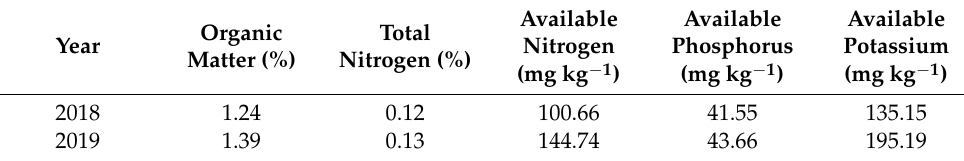
Figure 2. Daily solar radiation, rainfall, and maximum and minimum air temperature at the experi- mental station. Table 1. The basic soil characteristics of the experimental sites before